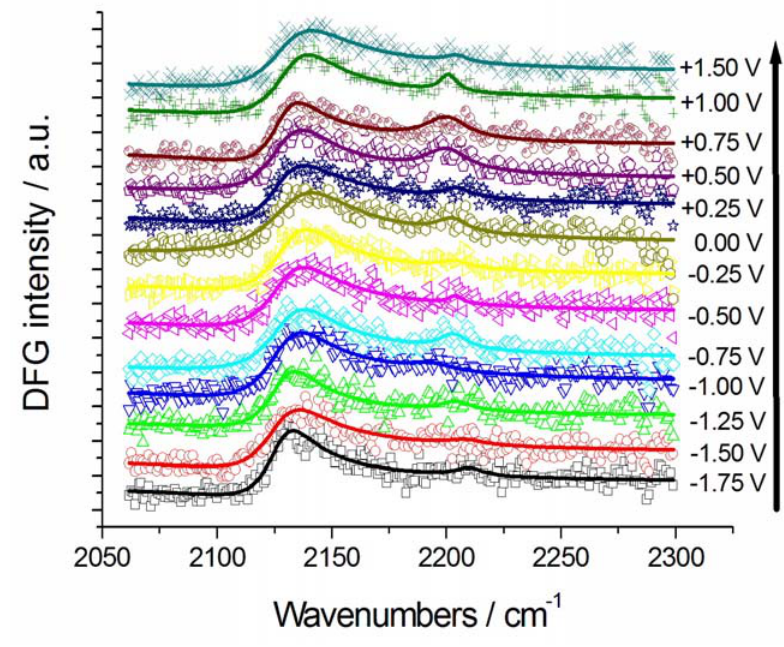
Figure 3. Potential-dependent DFG spectra of Au in contact with [BMP][TFSA] containing 1 mM CTDB and the corresponding fits: Anodic-going scan (from − 1.75 V to +1.50 V, measurements performed after those reported in Figure 2). The potential scan sequence (anodic-going scan) is indicated by the arrow.